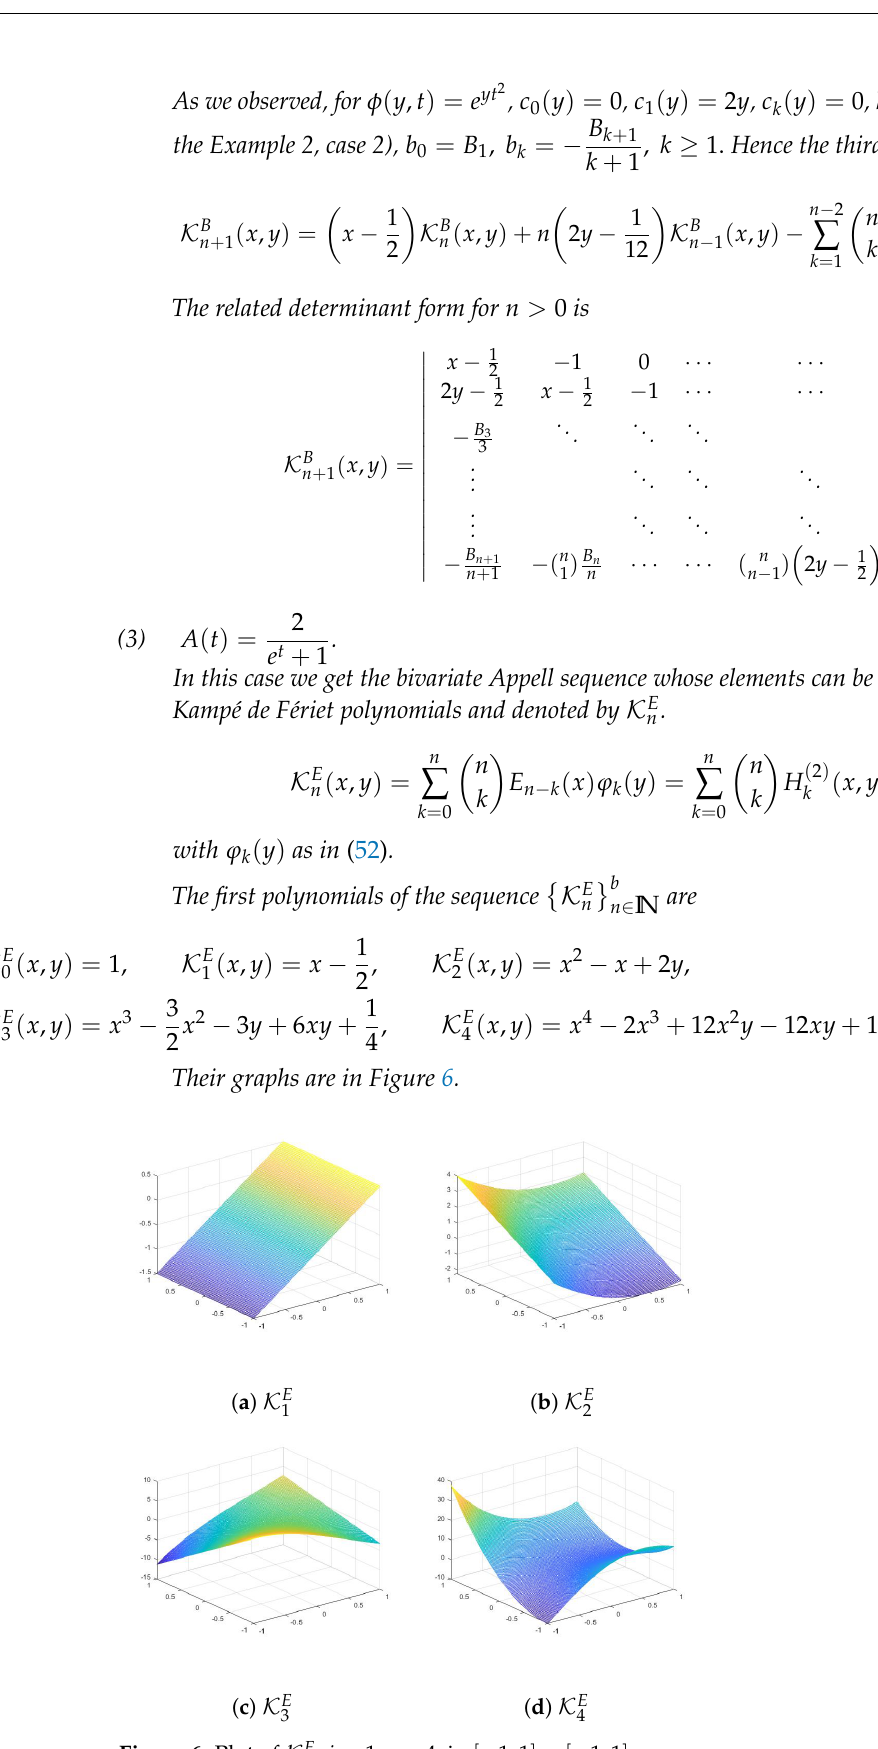
, i = 1, . . . ,4, in [ − 1,1 ] × [ − 1,1 ] i